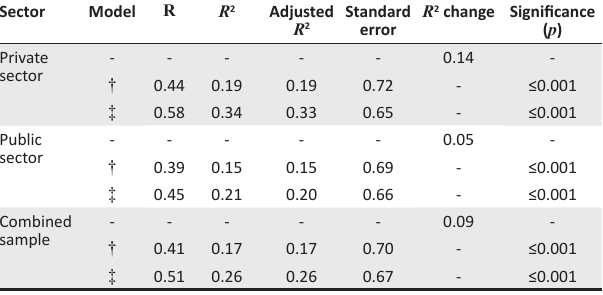
TABLE 5: Model summary of regression analysis – Variance explained in hope and optimism by team-based learning and servant leadership. Sector Model